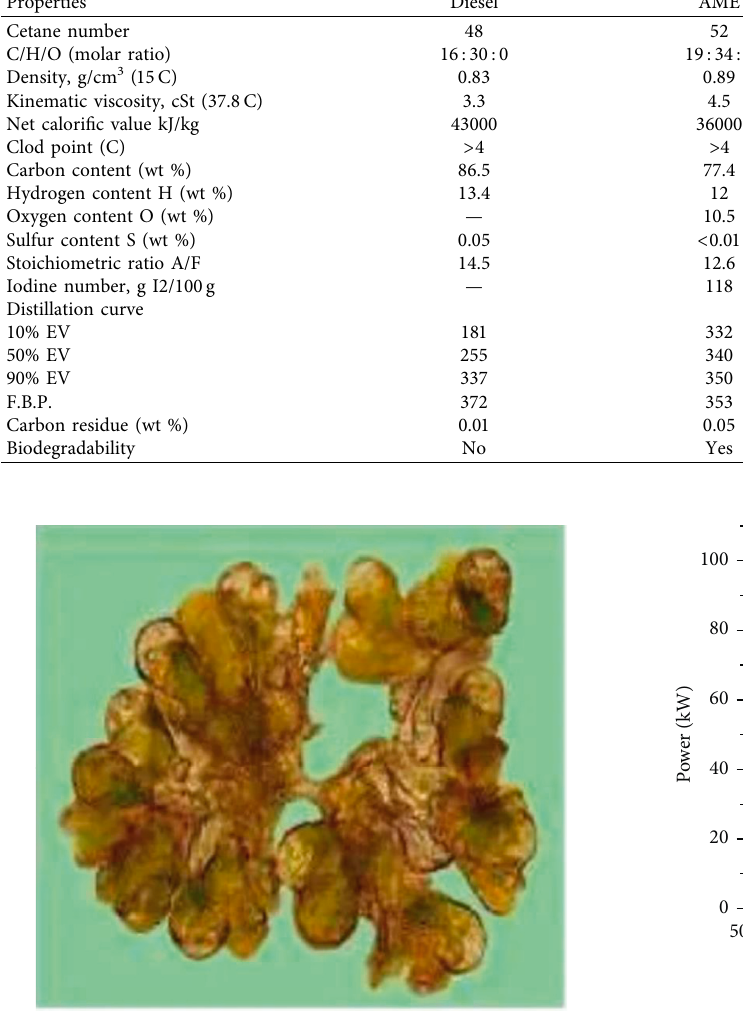
Figure 2: A photo view of Botryococcus braunii algae.